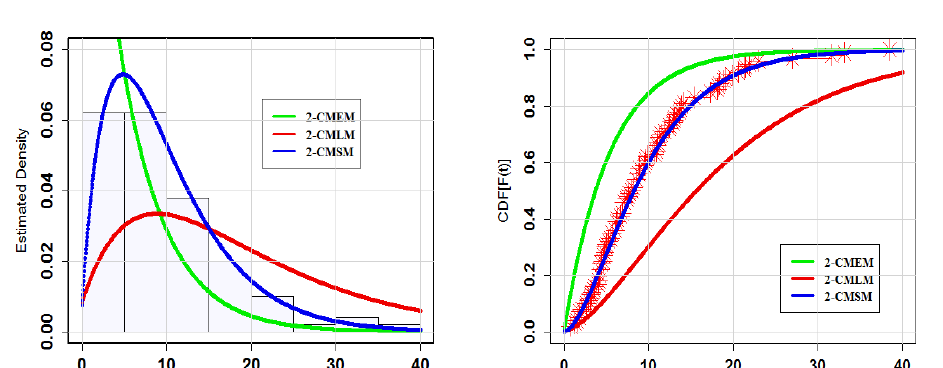
Fig. 15. Plots for the estimated PDFs and CDFs for Dataset I. Figure 15. Plots for the estimated PDFs and CDFs for Dataset